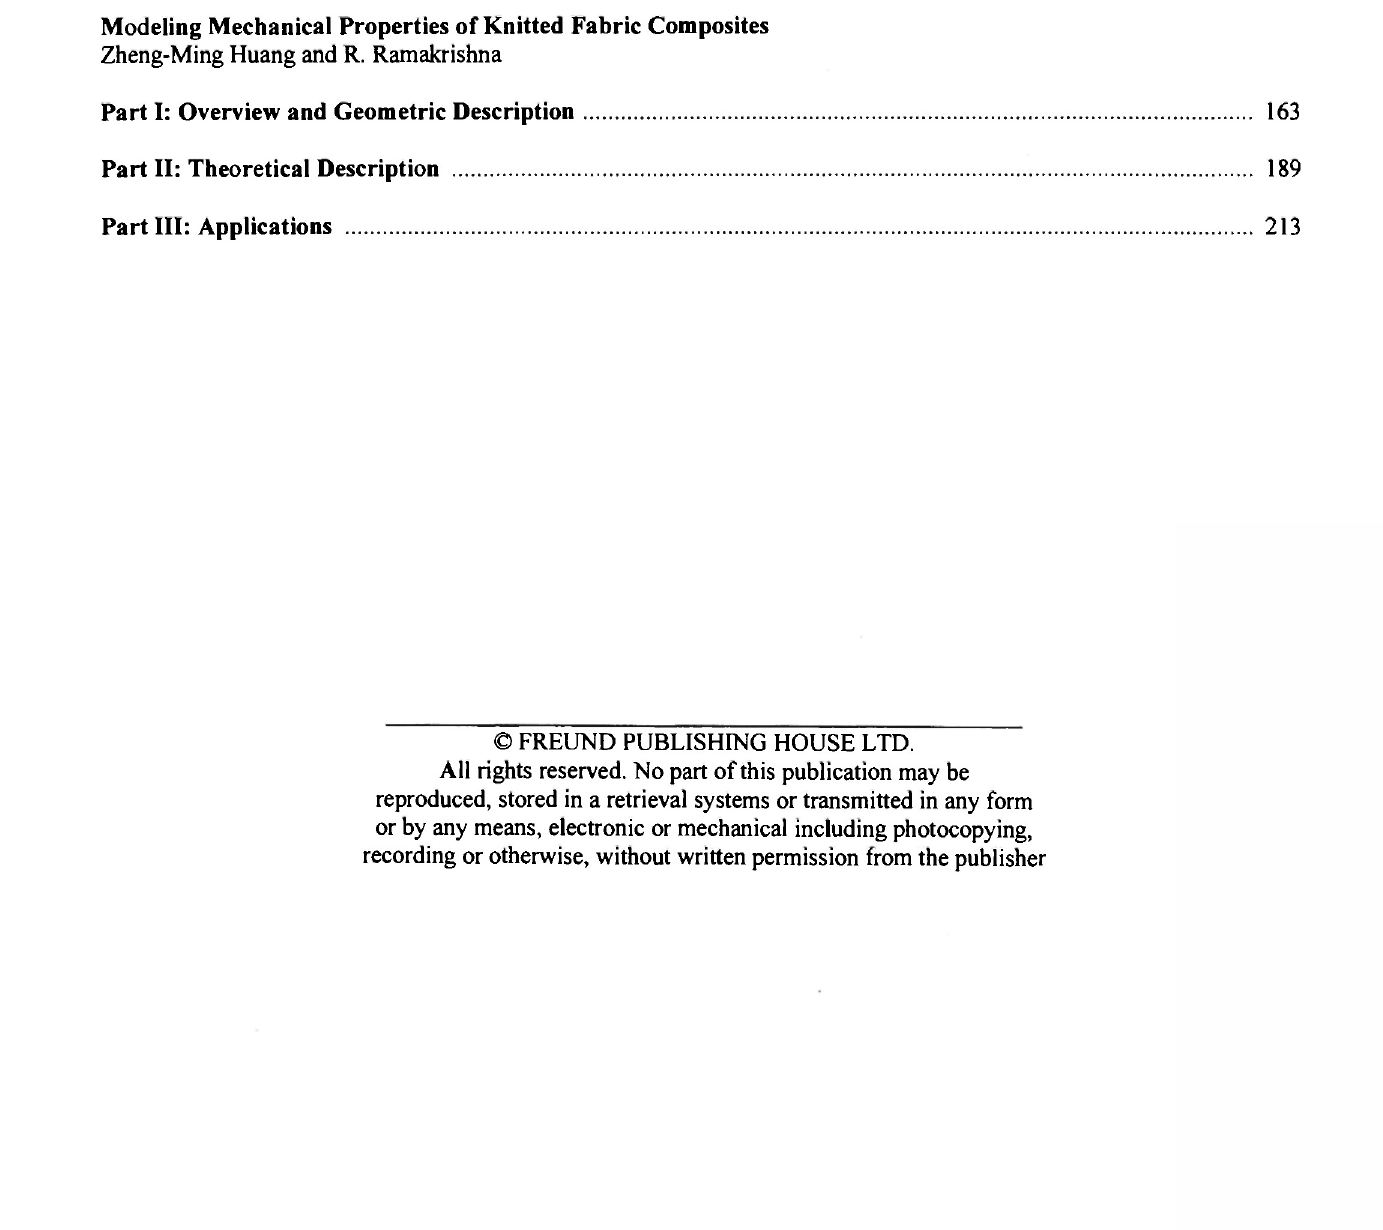
Modeling Mechanical Properties of Knitted Fabric Composites Zheng-Ming Huang and R. Ramakrishna Part I: Overview and Geometric